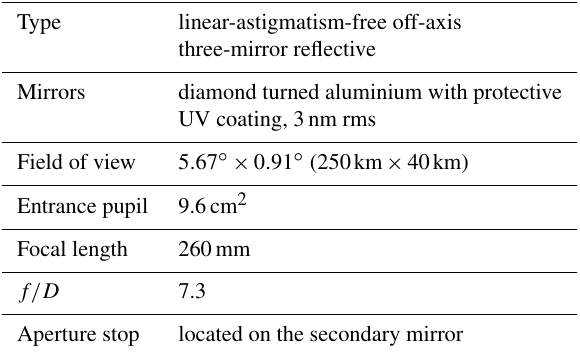
Table 3. Overview of optical properties of the MATS limb tele-